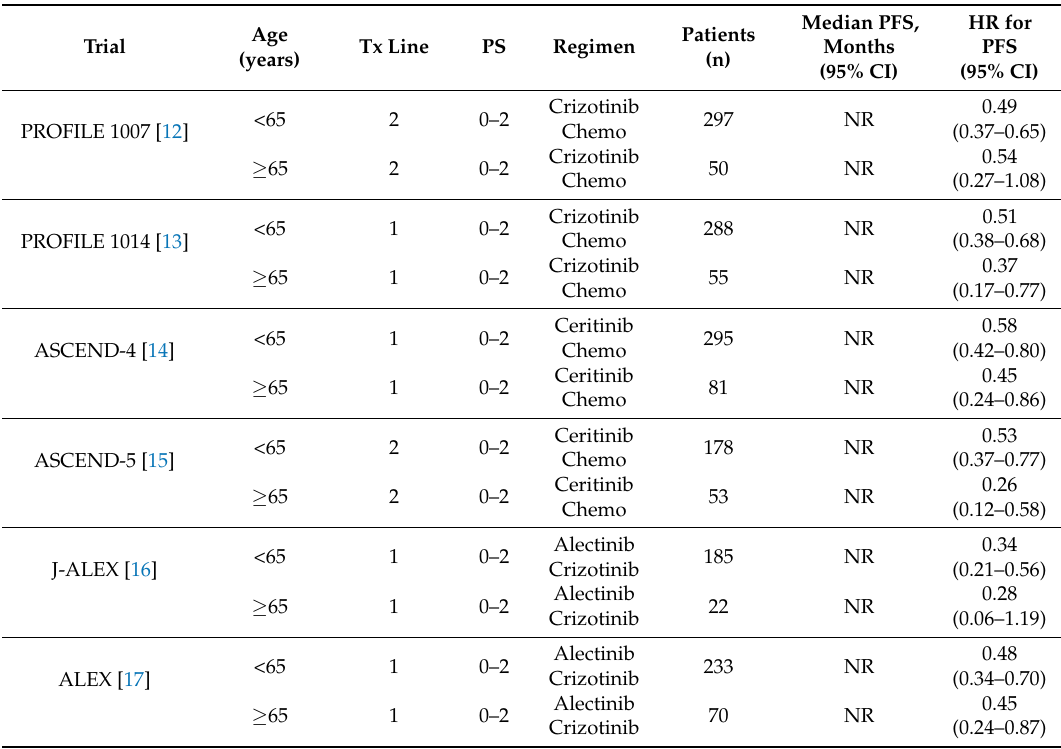
Table 2. Sub-group analyses of elderly patients in phase III trials of ALK inhibitors in patients with advanced